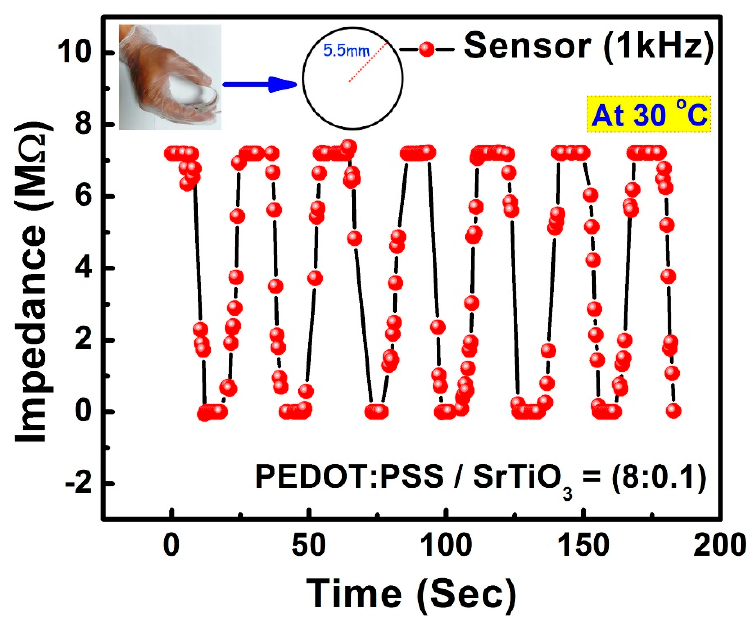
Figure 10. Response of the sensor to humidity-sensing under continuous mechanical bending with a radius of 5.5 mm.